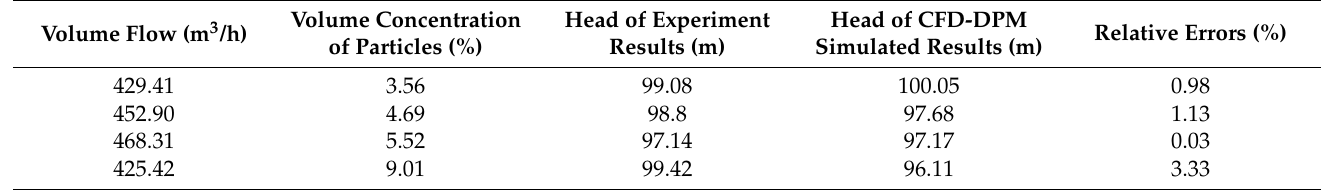
Table 4. Comparison of the experimental and CFD-DPM simulated